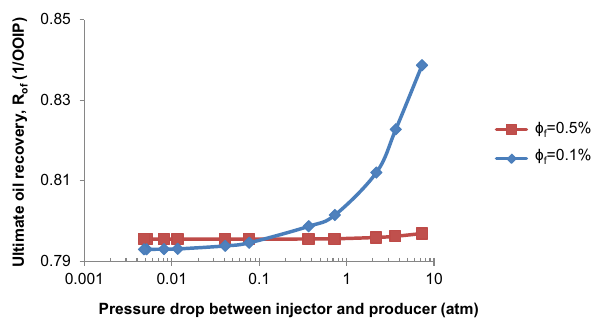
Fig. 15 The relationship between ultimate oil recovery and pressure drop between the injector and producer when the fracture porosity is 0.5% and 0.1%